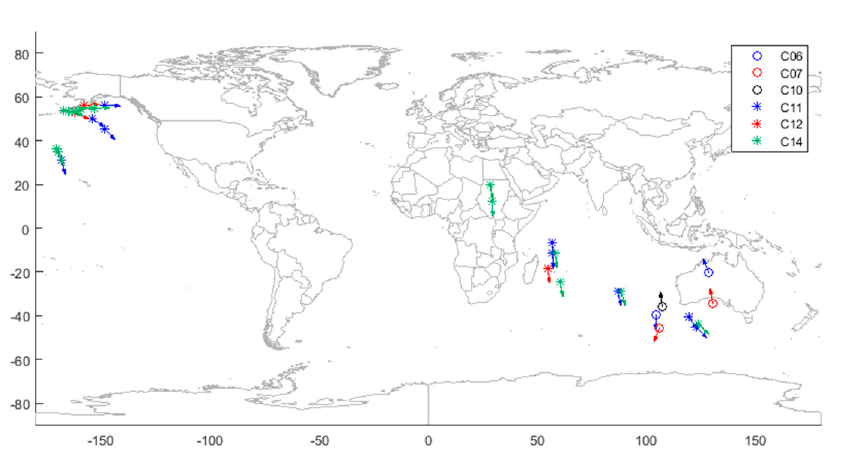
Figure 7. Satellite position and direction of motion corresponding to unhealthy states caused by satellite departure or entry.